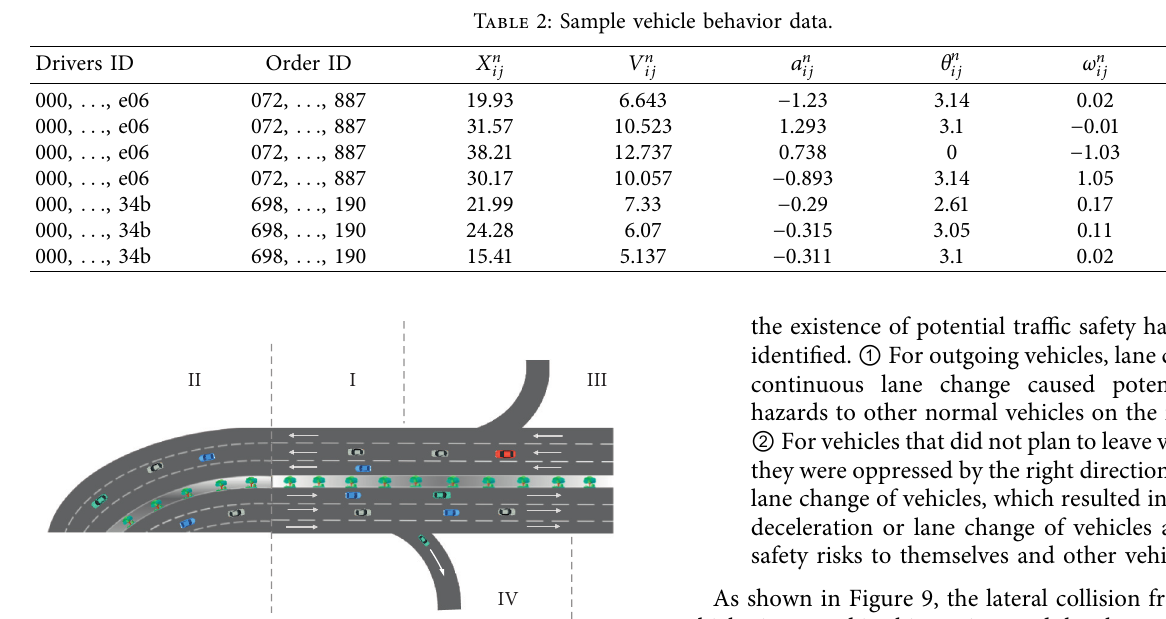
Figure 5: Urban expressway section type division.